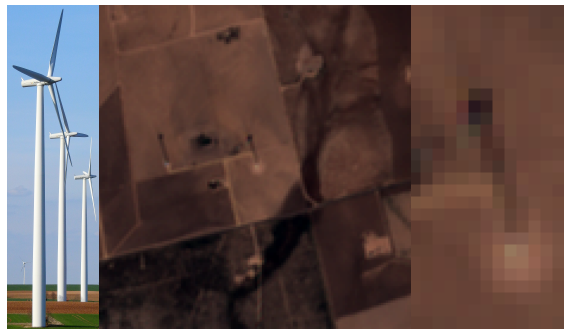
Figure 1. Pictures of wind turbines. Left, seen from the ground. If we ignore the blades, we can see its T-shape: we call tower the vertical bar and hub the top horizontal bar. Middle, scene of a wind farm acquired with Sentinel-2. Right, detail of middle picture on the central wind turbine. We can spot it thanks to its dark shadow and its bright hub. This example is one of the most visible case we can get with Sentinel-2